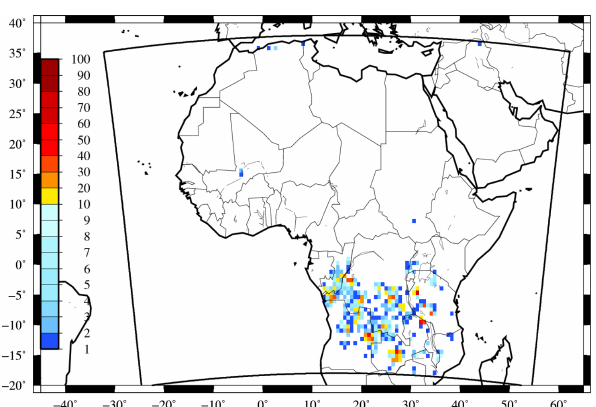
Figure D1. Biomass burning emission fluxes of CO (in moleculescm − 2 month − 1 ) cumulated over the whole month of July